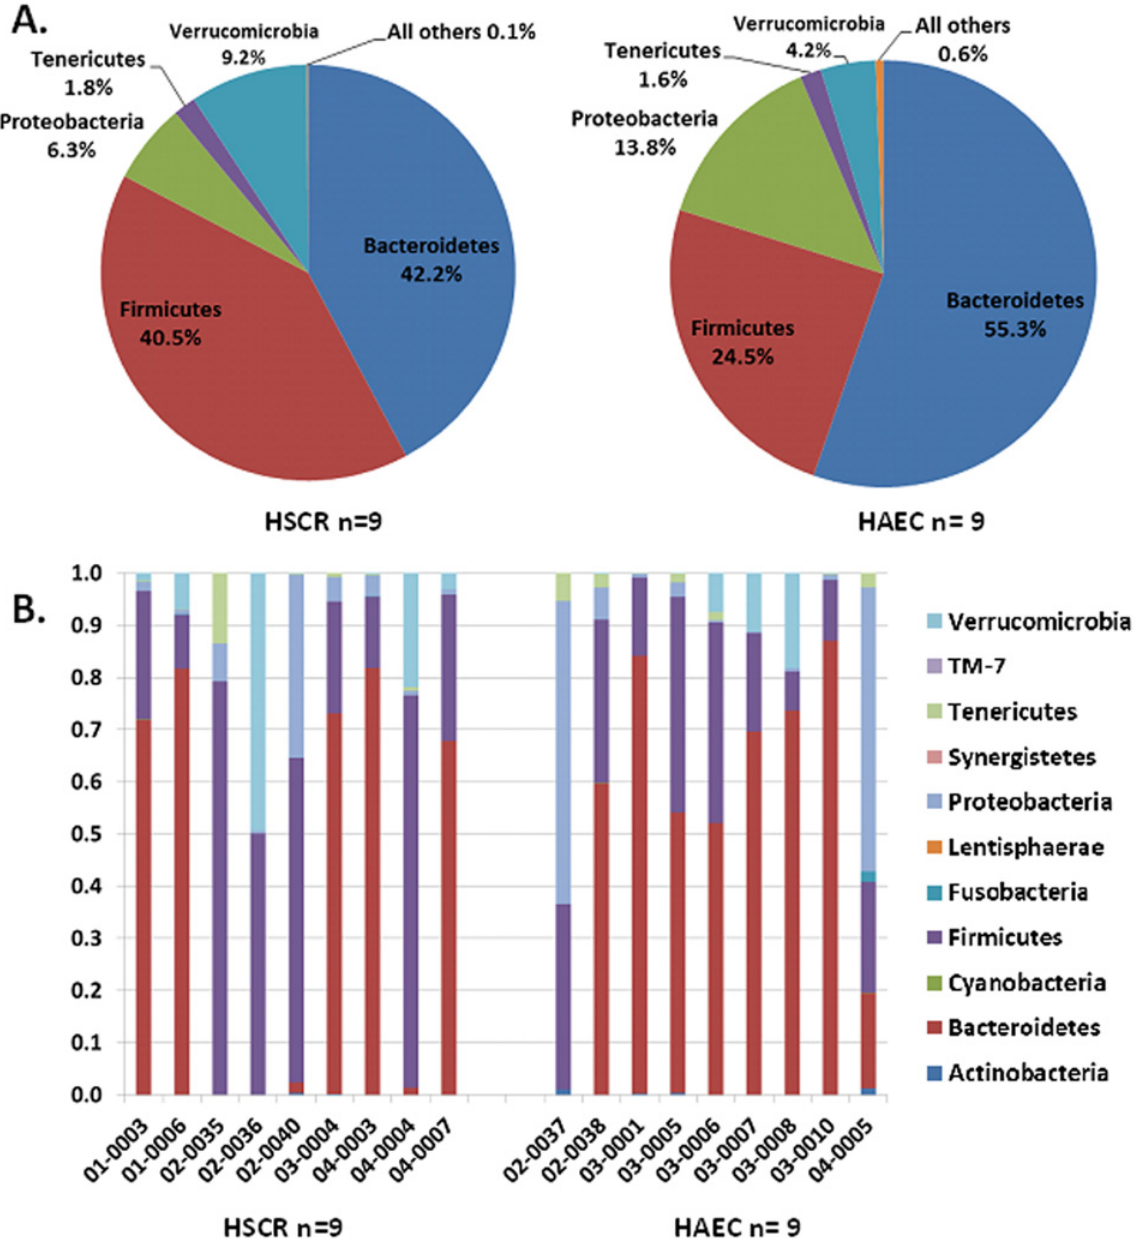
Fig 1. Bacterial phyla in HSCR and HAEC patients. A,16S rRNA gene sequence of fecal bacteria of nine HSCR patients and nine HAEC patients. The pie charts show average relative abundance of five major phyla and six subdominant phyla (summarized as “ All others ” ). B, histograms demonstrating the phyla level bacterial composition of individual subjects with HSCR and HAEC. Individual subject numbers are labeled on the X axis and expressed as relative OTU abundance per each subject. Colors were assigned for each of the 11 detected phyla with the scheme at the right side.